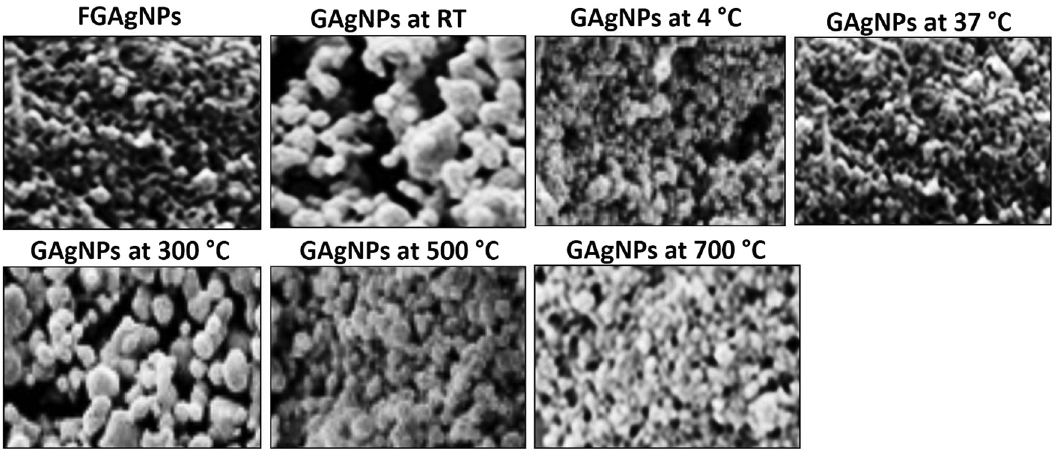
Figure 2: Scanning electron microscopy of synthesized silver nanoparticles using A. sativum clove